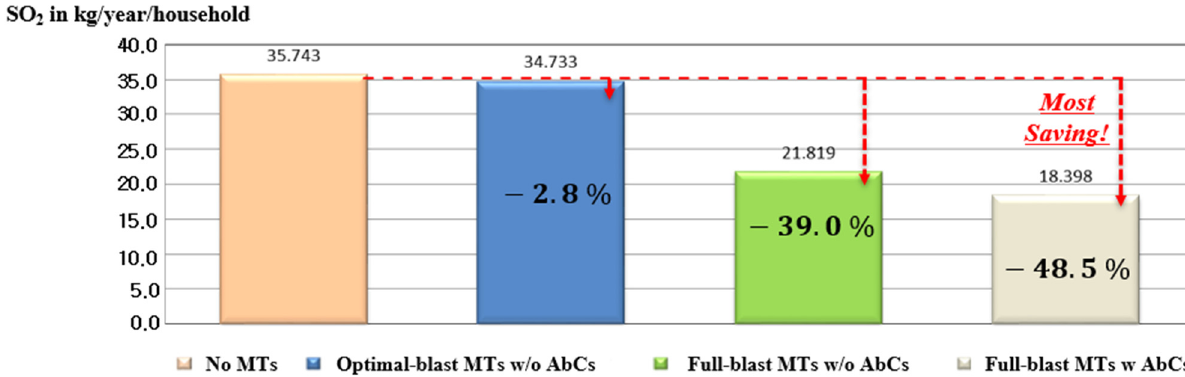
Figure 18. SO 2 emissions savings (scenario 2).